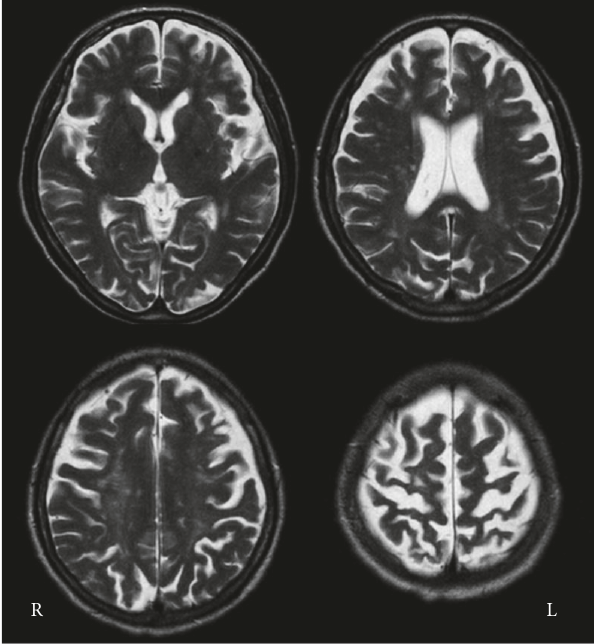
Figure 1: Axial T2-weighted magnetic resonance imaging 2 days after admission showing small infarctions in the deep white matter and subcortical high-signal intensities in both hemispheres. Diffuse cortical atrophy that is more prominent in the central areas is also demonstrated. Note that neither ischemic nor atrophic changes are present in the basal ganglia.